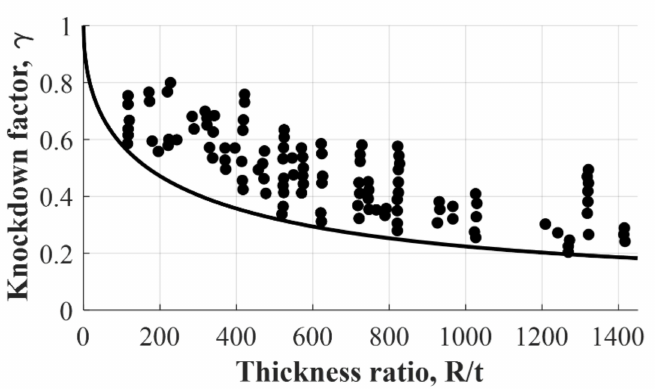
Figure 1. NASA’s lower bound of knockdown factors